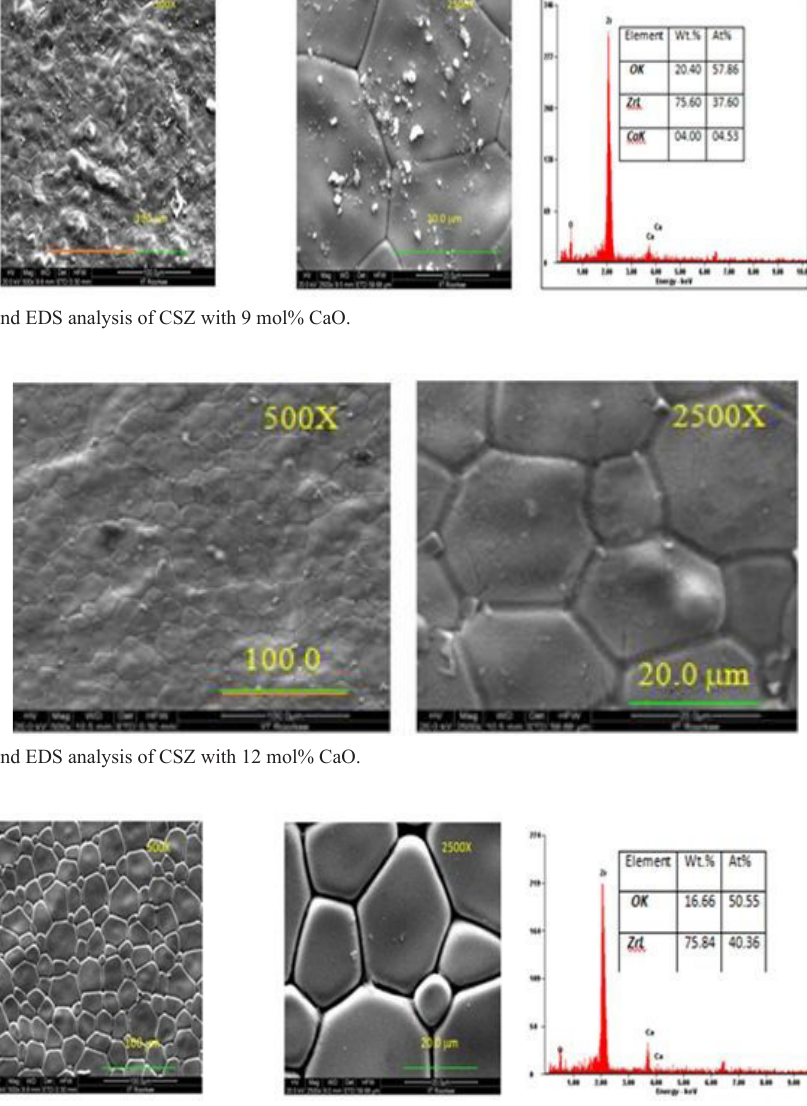
Figure 7. SEM and EDS analysis of CSZ with 15 mol%